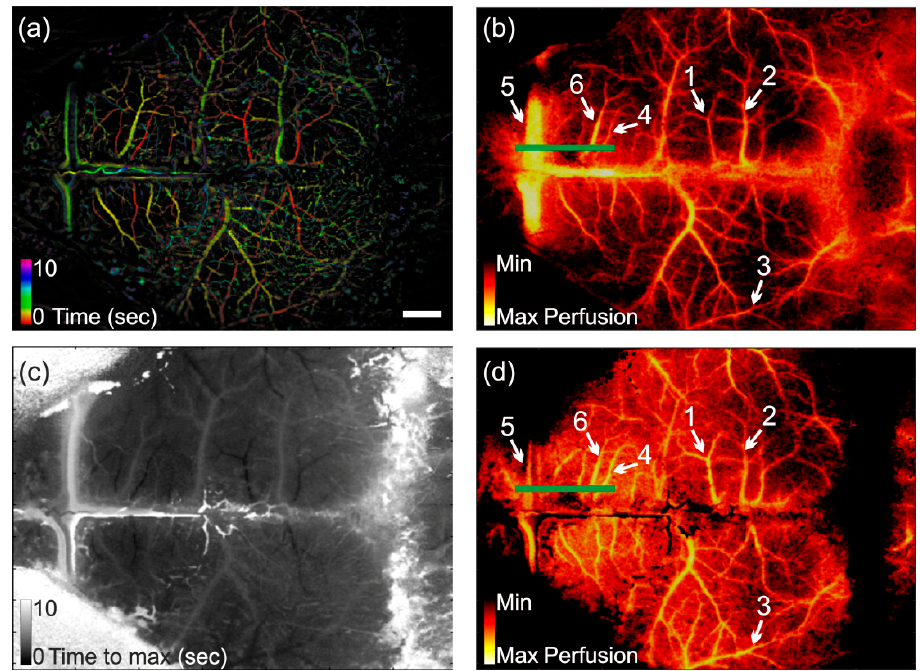
Figure 2. ( a ) Color-coded DF image of mouse brain distinguishing veins and arteries. Red colors correspond to arteries, whereas green colors correspond to the veins; ( b ) Speckle contrast image of mouse brain before correction procedure; ( c ) Fluorescence time to maximum image; ( d ) Speckle contrast image of mouse brain after correction procedure. Scale bar (white line) is equal to 1 mm. The green line represents the line for contrast intensity profiles calculation.